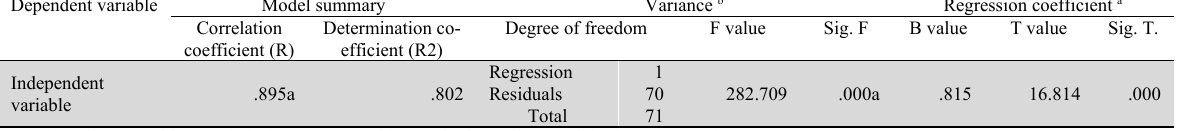
The results of the simple regression analysis for testing the second sub-hypothesis